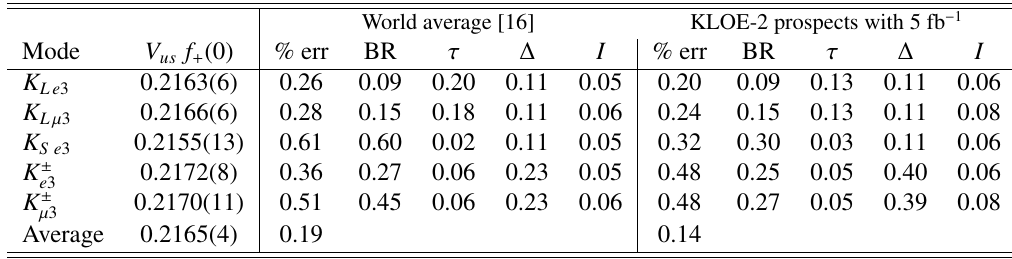
Table 2. Comparison of world average value of V us f + (0) [16] with KLOE-2 prospects [7].